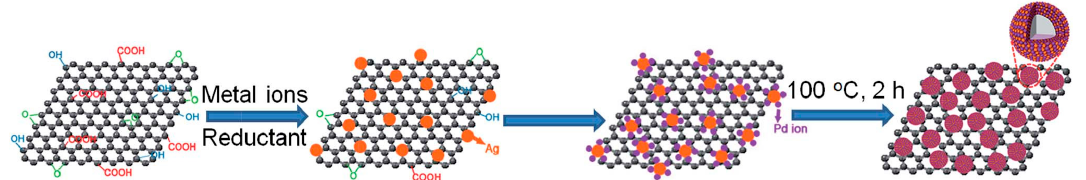
Figure 1. Schematic illustration for the preparation of AgPd-Hs / G. The preparation involves the redox reaction between the Pd ions and Ag nanoparticles. Reprinted with permission from